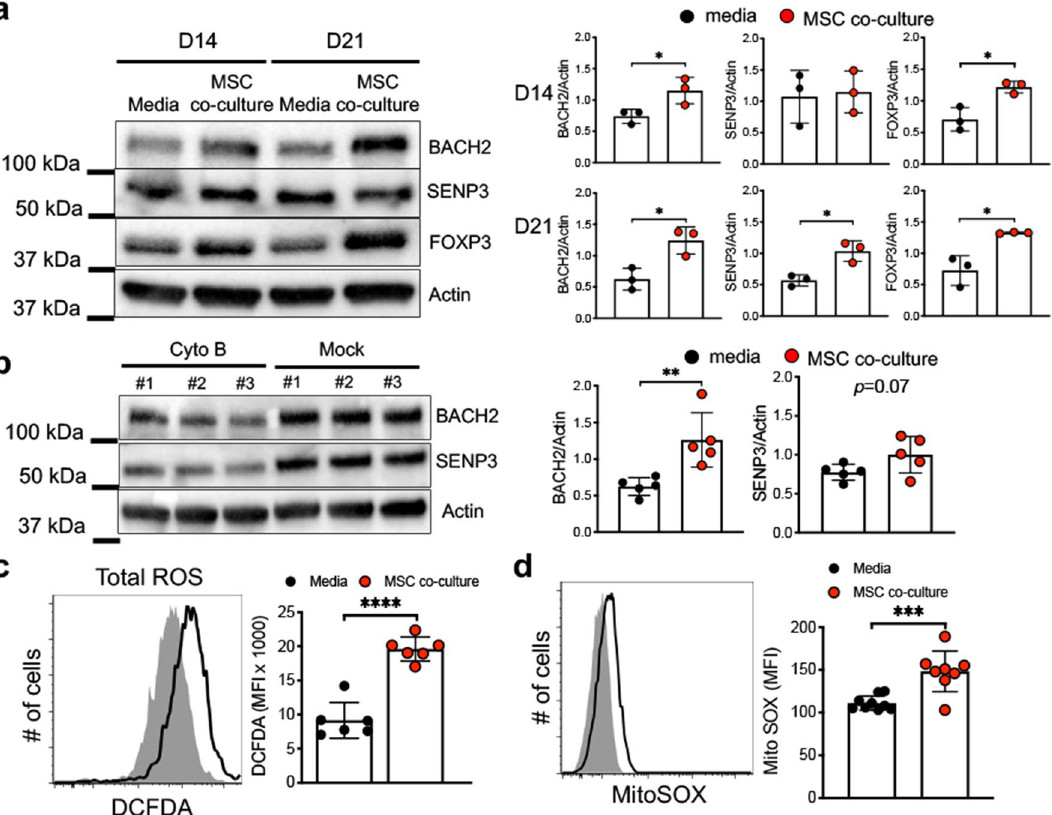
Figure 6. MSC co-culture induces iTreg BACH2 and SENP3 via ROS. ( a ) Expression of BACH2, SENP3, and FOXP3 on iTregs was measured by immunoblot assay. iTregs were expanded in media vs MSC co-culture and protein was isolated at indicated time. Data are representative of n = 3 independent samples. ( b ) Analysis of BACH2 and SENP3 on iTregs after CD39 signaling inhibition. iTregs were expanded in media vs MSC co-culture and protein was isolated at indicated time. Expression was measured by immunoblot assay. ( c , d ) Expression of intracellular reactive oxygen species (ROS) was measured by flow cytometry in media vs MSC co-culture expanded iTregs ( c ) expression of mitochondrial ROS was measured by FACS analysis ( d ) at 21 days expansion. Data are representative of n = 6 independent experiments. * p < 0.05, ** p < 0.01, *** p < 0.001, **** p < 0.0001 paired t test. See also Supplementary Fig.